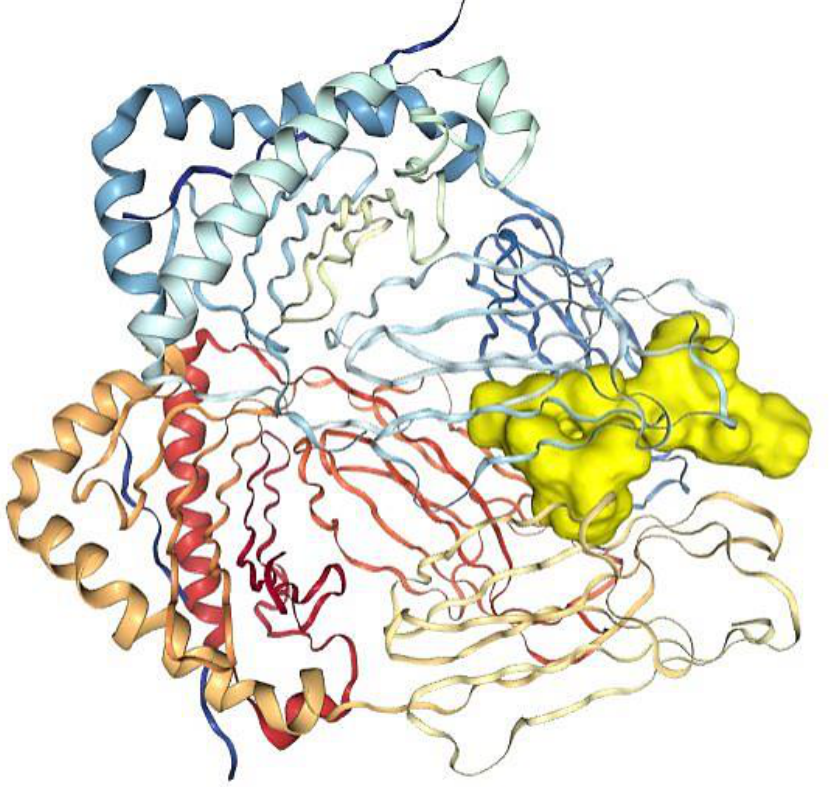
Figure 5. The peptide VQLSLPVLQ is shown in the surface (yellow) format which has been docked against the HLA DRB1*04-01, displayed in the ribbon format. The format of the allele and the peptide are differed on purpose to show